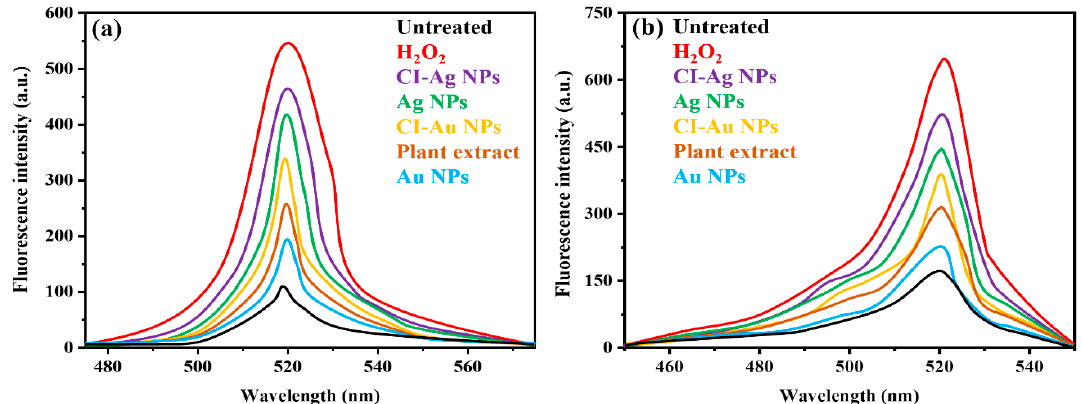
Figure 9. Fluorescent spectra measured with a confocal microscope from the H 2 -DCFDA probe inside ( a ) E. coli and ( b ) A. flavus cells after incubating with different samples.